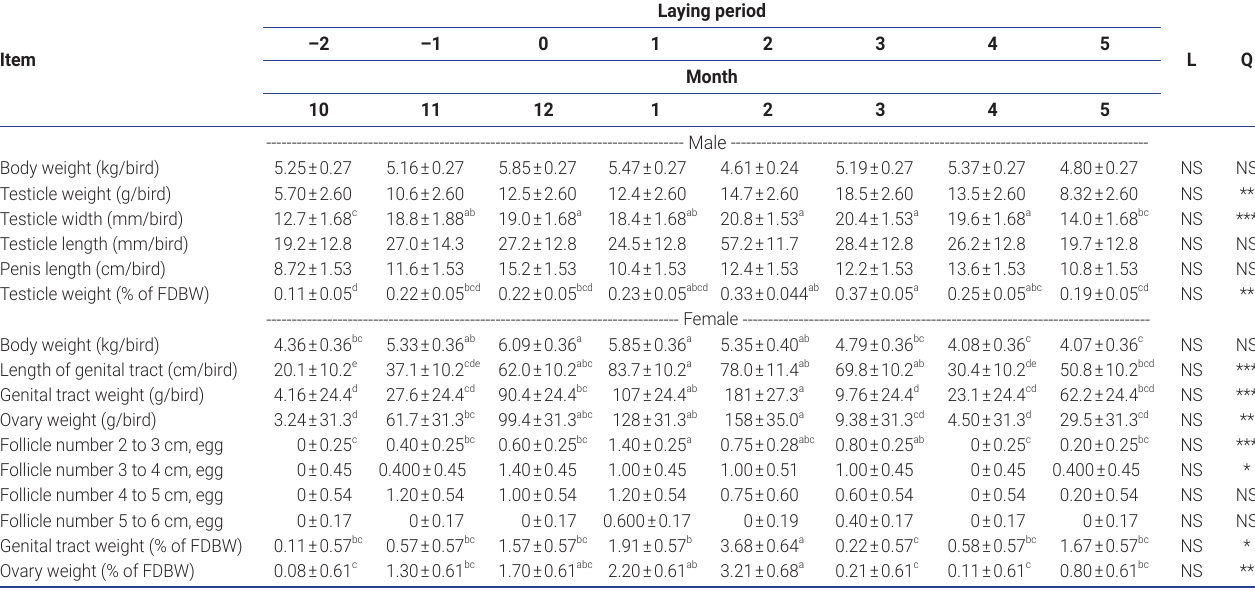
Table 1. Effect of reproduction system of breeding geese at various egg production months